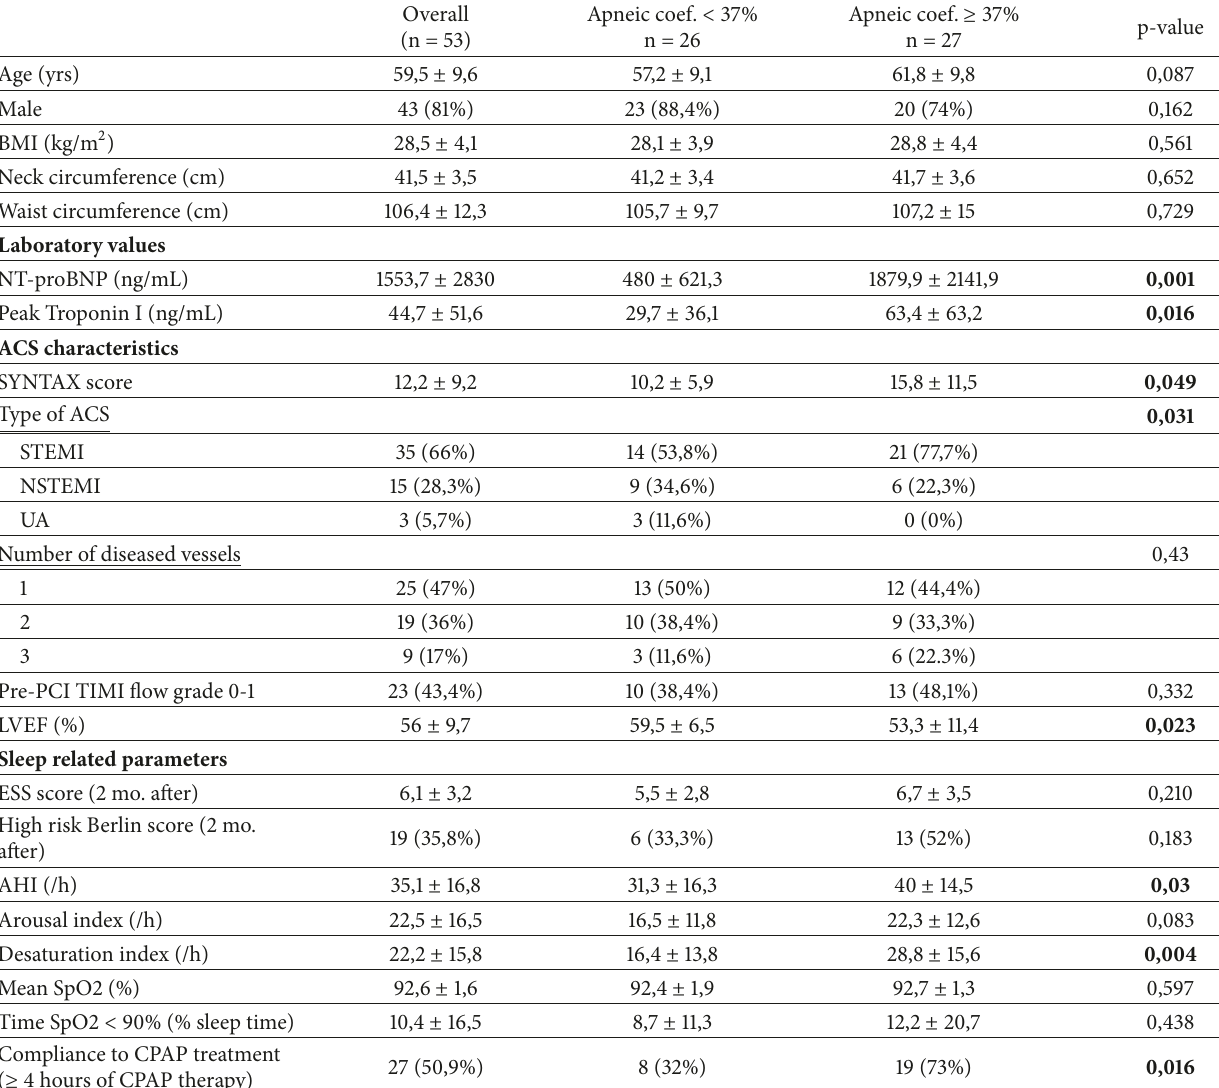
Table 2: Comparison between the more apneic patients vs. less apneic patients. Data are expressed as mean ± SD or number (%). ACS, acute coronary syndrome; STEMI, ST elevation myocardial infarction; UA, unstable angina; PCI, percutaneous coronary intervention; LVEF, left